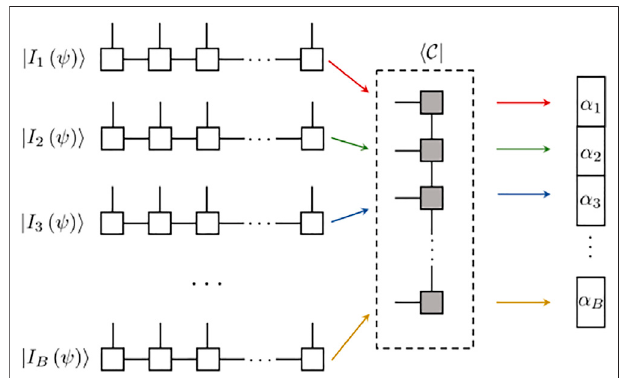
FIGURE 5 | Schematics of inputting individual data as the MPS (| I j ( ψ ) 〉 ) onto the core model ( 〈 C |) : each operation follows the arrow with the same color, and results in an outcome α j